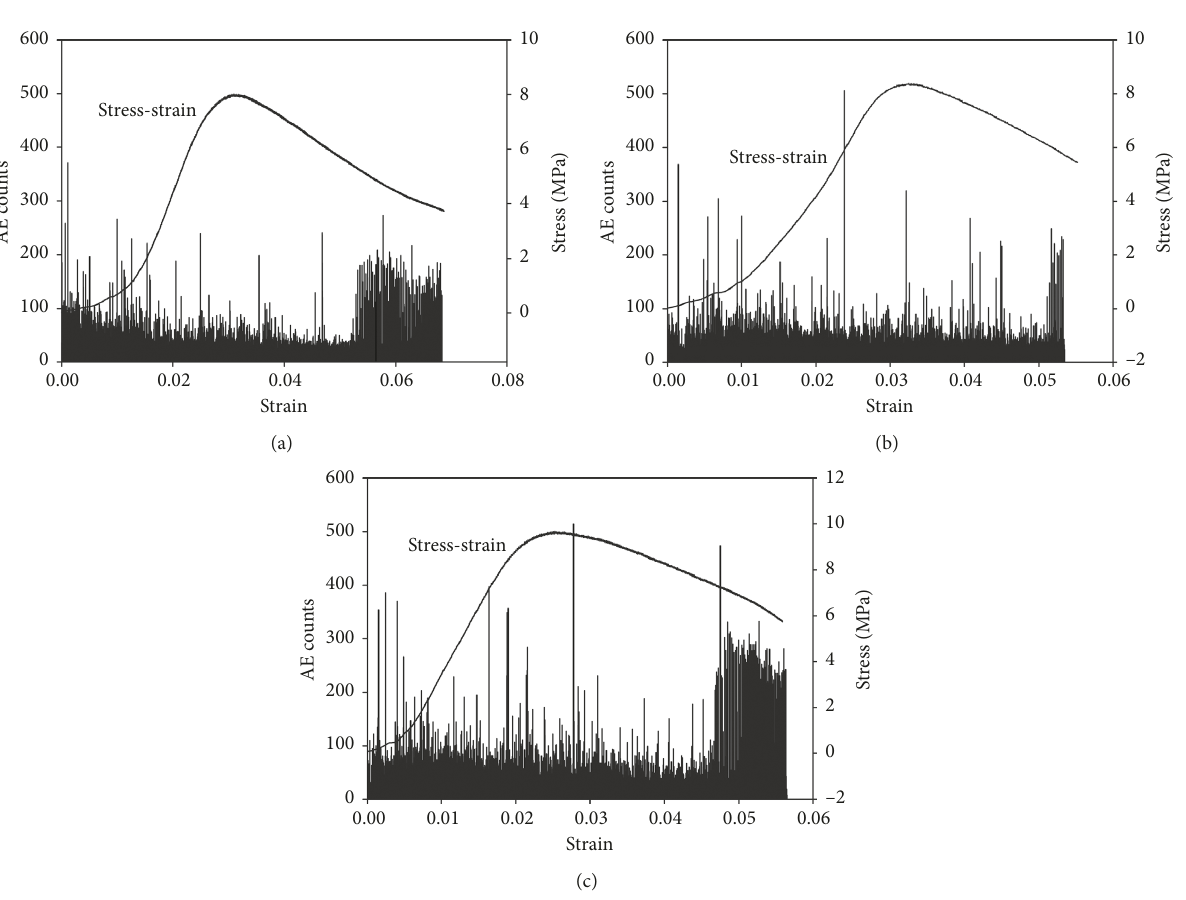
Figure 4: Relational graph of the CGB and CWCGB stress and AE counts. (a) No adding waste concrete. (b) 30% waste concrete substitution. (c) 50% waste concrete